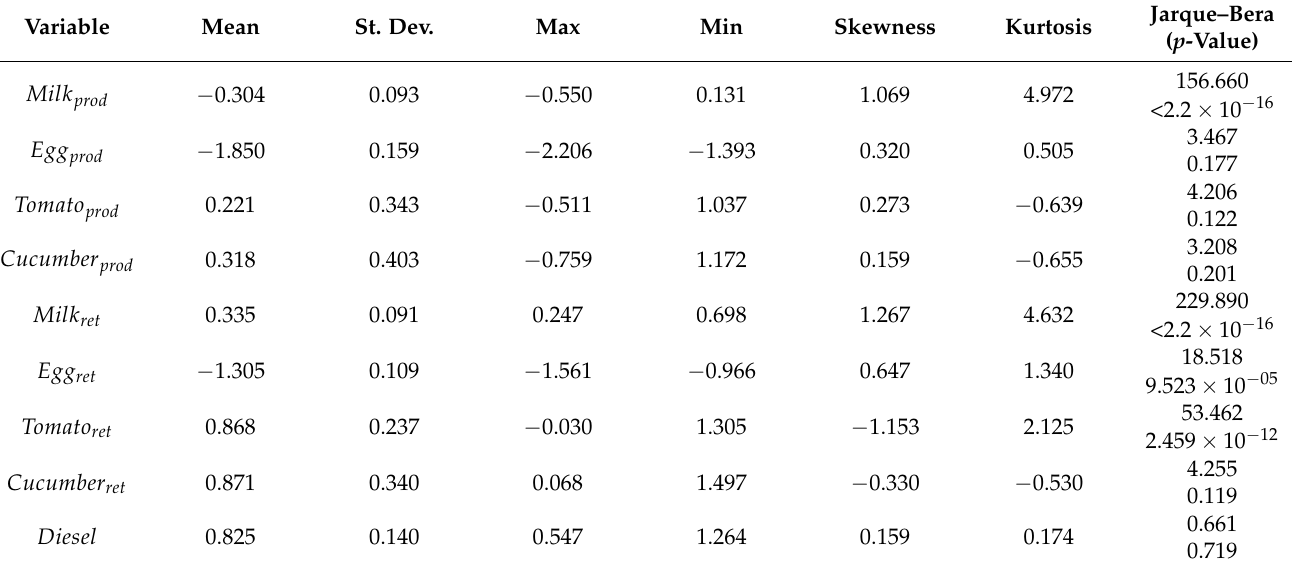
Table 1. Descriptive statistics results of the variables between January 2011 to July 2022.